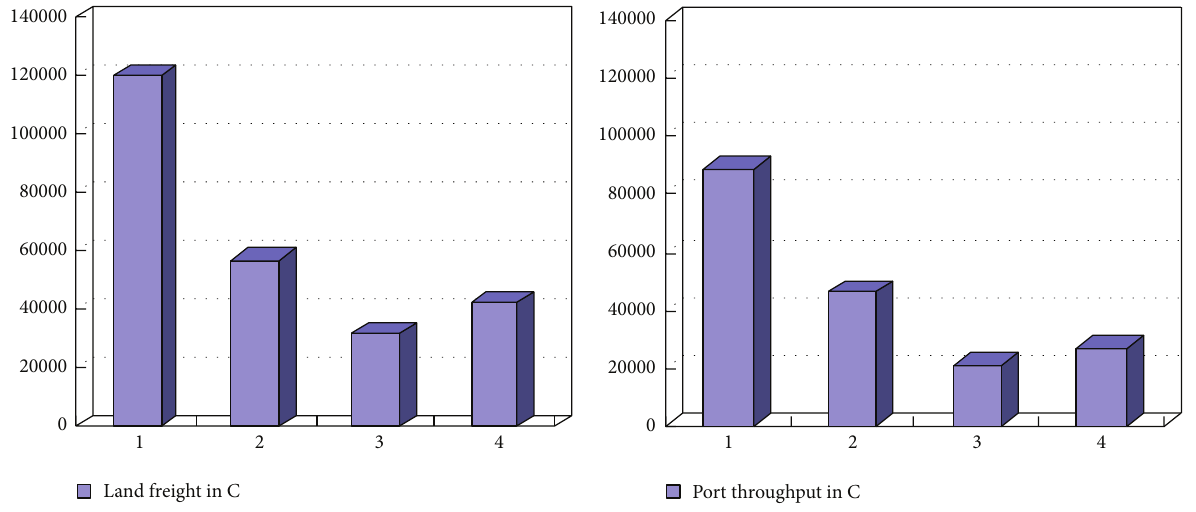
Figure 7: Freight volume of C in different schemes.